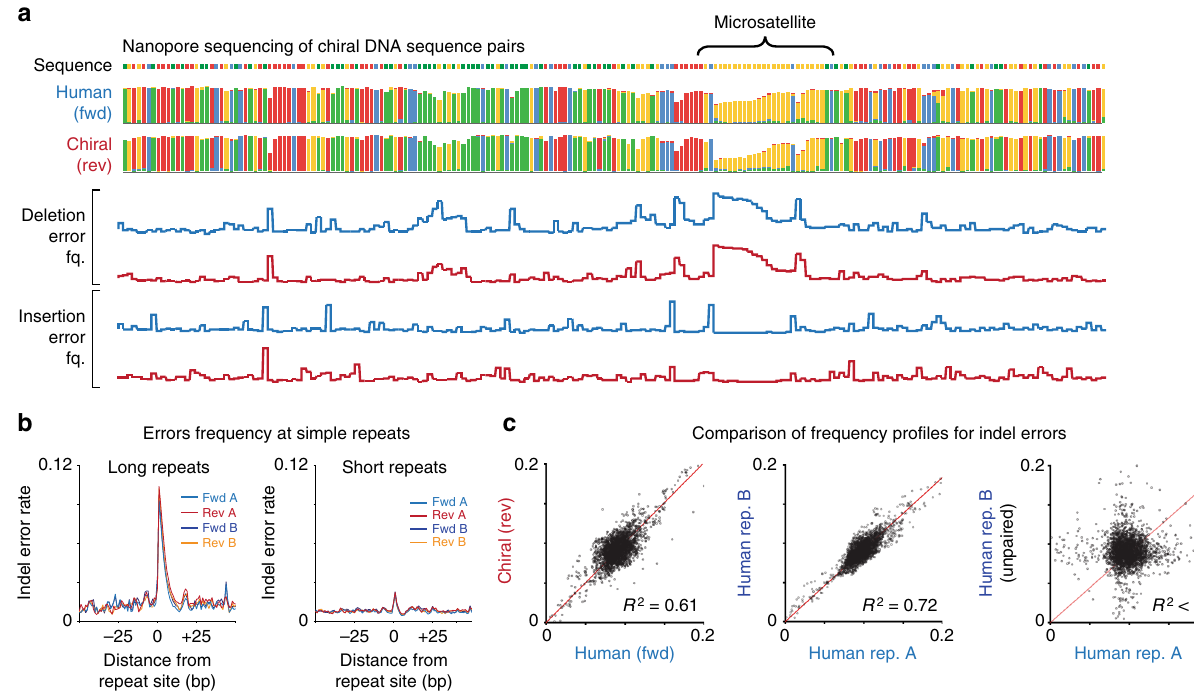
Fig. 4 Matched performance of chiral DNA sequence pairs during nanopore sequencing. a Genome browser view (200 bp window) shows sequence identity and per-base insertion and deletion error frequencies within a synthetic human sequence ( fwd ; blue) and its chiral partner sequence ( rev ; red) analyzed by nanopore sequencing (Oxford Nanopore MinION). b Normalized indel error frequencies for human and chiral sequences aggregated w.r.t. sites of long repeats (>10nt; left) and short repeats (5 – 9 repeats; right). c Scatter plots show concordance of indel sequencing error frequency pro fi les between synthetic human and chiral ( fwd/rev ) DNA sequence pairs (left). For comparison, the concordance of identical human ( fwd/fwd ) sequences (middle) and unpaired sequences (right) between replicate experiments are also